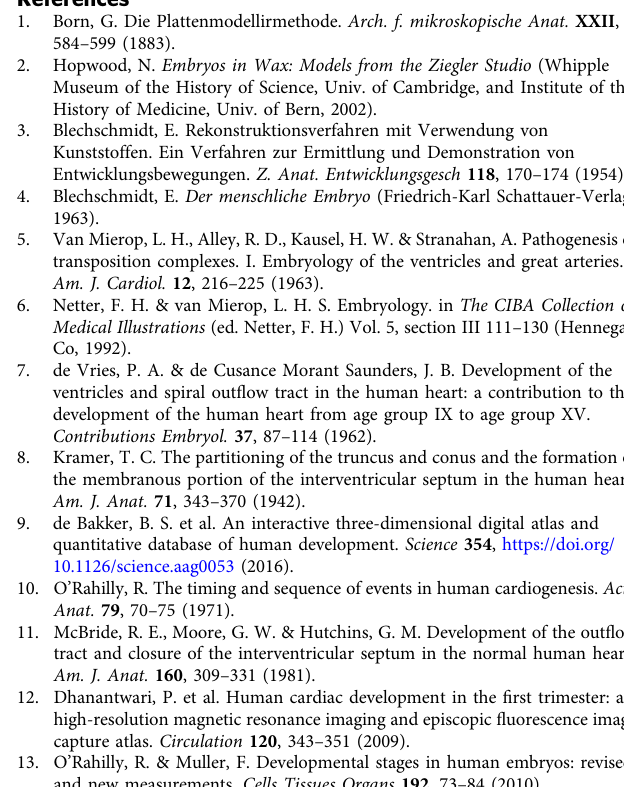
Supplemental Table 1: https://doi.org/10.6084/m9. fi gshare.19102571; Supplemental Table 2: https://doi.org/10.6084/m9. fi gshare.17144156; Supplemental Table 3: https://doi.org/10.6084/ m9. fi gshare.17121977; Instruction video Supplemental Figs. 1 – 12: https://doi.org/10.6084/ m9. fi gshare.17033225; Supplemental Fig. 1: https://doi.org/10.6084/m9. fi gshare.17033156; Supplemental Fig. 2: https://doi.org/10.6084/m9. fi gshare.17033189; Supplemental Fig. 3: https://doi.org/10.6084/m9. fi gshare.17033249; Supplemental Fig. 4: https://doi.org/10.6084/ m9. fi gshare.17033252; Supplemental Fig. 5: https://doi.org/10.6084/m9. fi gshare.17033255; Supplemental Fig. 6: https://doi.org/10.6084/m9. fi gshare.17085503; Supplemental Fig. 7: https://doi.org/10.6084/m9. fi gshare.17085506; Supplemental Fig. 8: https://doi.org/10.6084/ m9. fi gshare.17085509; Supplemental Fig. 9: https://doi.org/10.6084/m9. fi gshare.17085512; Supplemental Fig. 10: https://doi.org/10.6084/m9. fi gshare.17085515; Supplemental Fig. 11: https://doi.org/10.6084/m9. fi gshare.17085521; Supplemental Fig. 12: https://doi.org/10.6084/ m9. fi gshare.17085524; Supplemental Fig. 13: https://doi.org/10.6084/m9. fi gshare.17143910; Supplemental Fig. 14: https://doi.org/10.6084/m9. fi gshare.19102616; Supplemental Fig. 15: https://doi.org/10.6084/m9. fi gshare.17143970; Supplemental Fig. 16: https://doi.org/10.6084/ m9. fi gshare.19102622; Supplemental Fig. 17: https://doi.org/10.6084/m9. fi gshare.17144036; Supplemental Fig. 18: https://doi.org/10.6084/m9. fi gshare.17144090; Supplemental Fig. 19: https://doi.org/10.6084/m9. fi